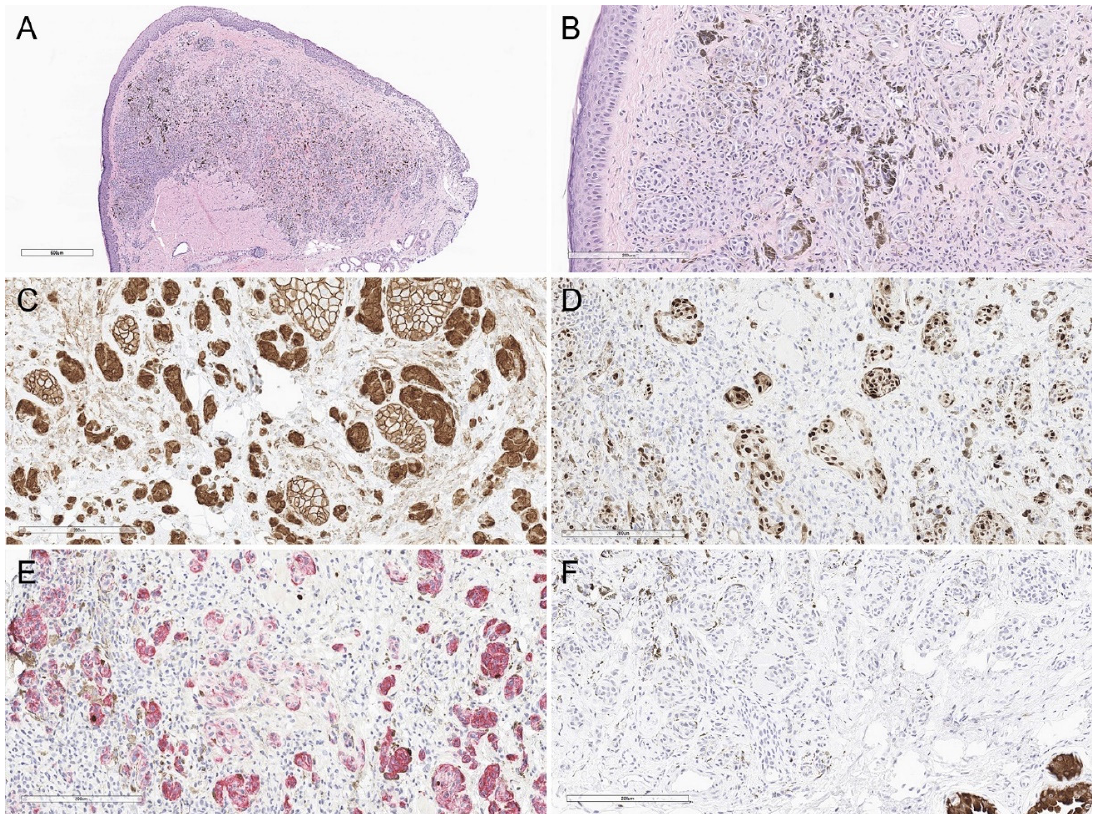
Figure 7. Atypical deep penetrating nevus from the eyelid margin. ( A ) Hematoxylin and eosin, 40 × . ( B ) Hematoxylin and eosin, 200 × . There is moderate cytologic atypia and rare mitotic figures. ( C – F ) Lesional cells demonstrate ( C ) membranous, cytoplasmic, and nuclear beta-catenin expression (beta-catenin, 200 × ), ( D ) nuclear cyclin D1 expression (cyclin D1, 200 × ), ( E ) a few proliferating melanocytes on a MART1/Ki67 immunostain (MART1/Ki67, 200 × ), and ( F ) no expression of preferentially expressed antigen in melanoma (PRAME) (PRAME, 200 ×